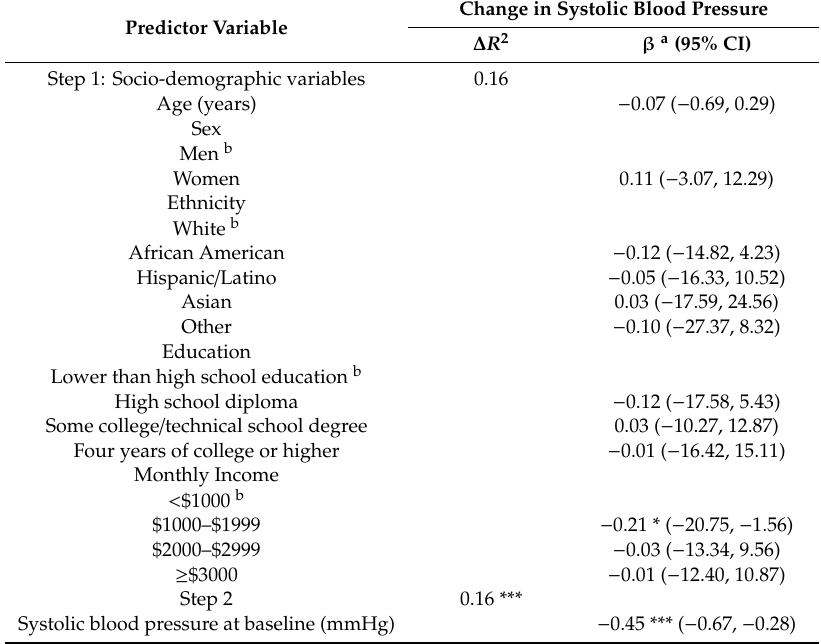
Table 2. Hierarchical multiple regression analyses examining the association of the lifestyle intervention e ff ect with change in systolic blood pressure ( n =